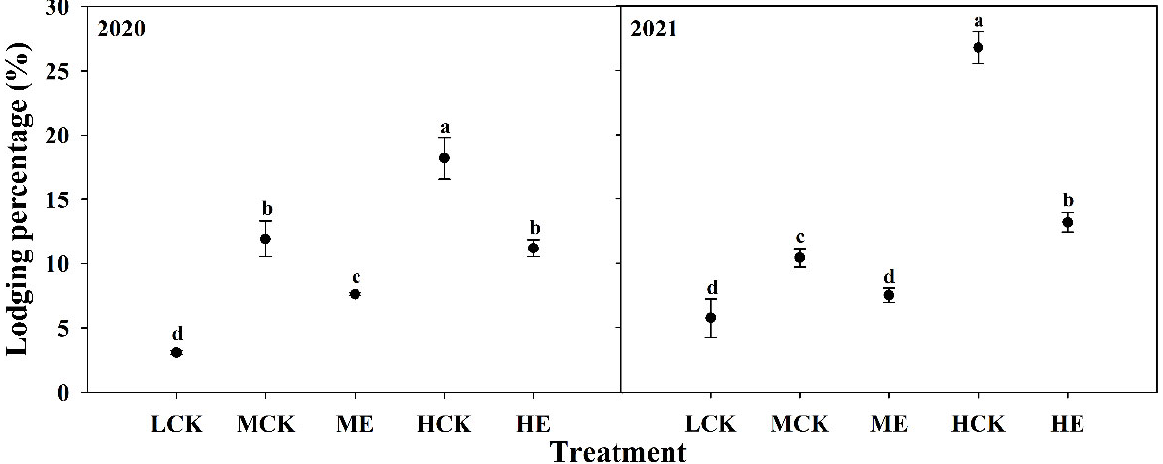
Figure 7. Effects of spraying ethephon on lodging percentage of summer maize. LCK, MCK, ME, HCK and HE were the treatments of low density control, medium density control, medium density sprayed with ethephon, high density control and high density sprayed with ethephon, respectively. Different lowercase letters in the figure indicated significant difference at 5% level.